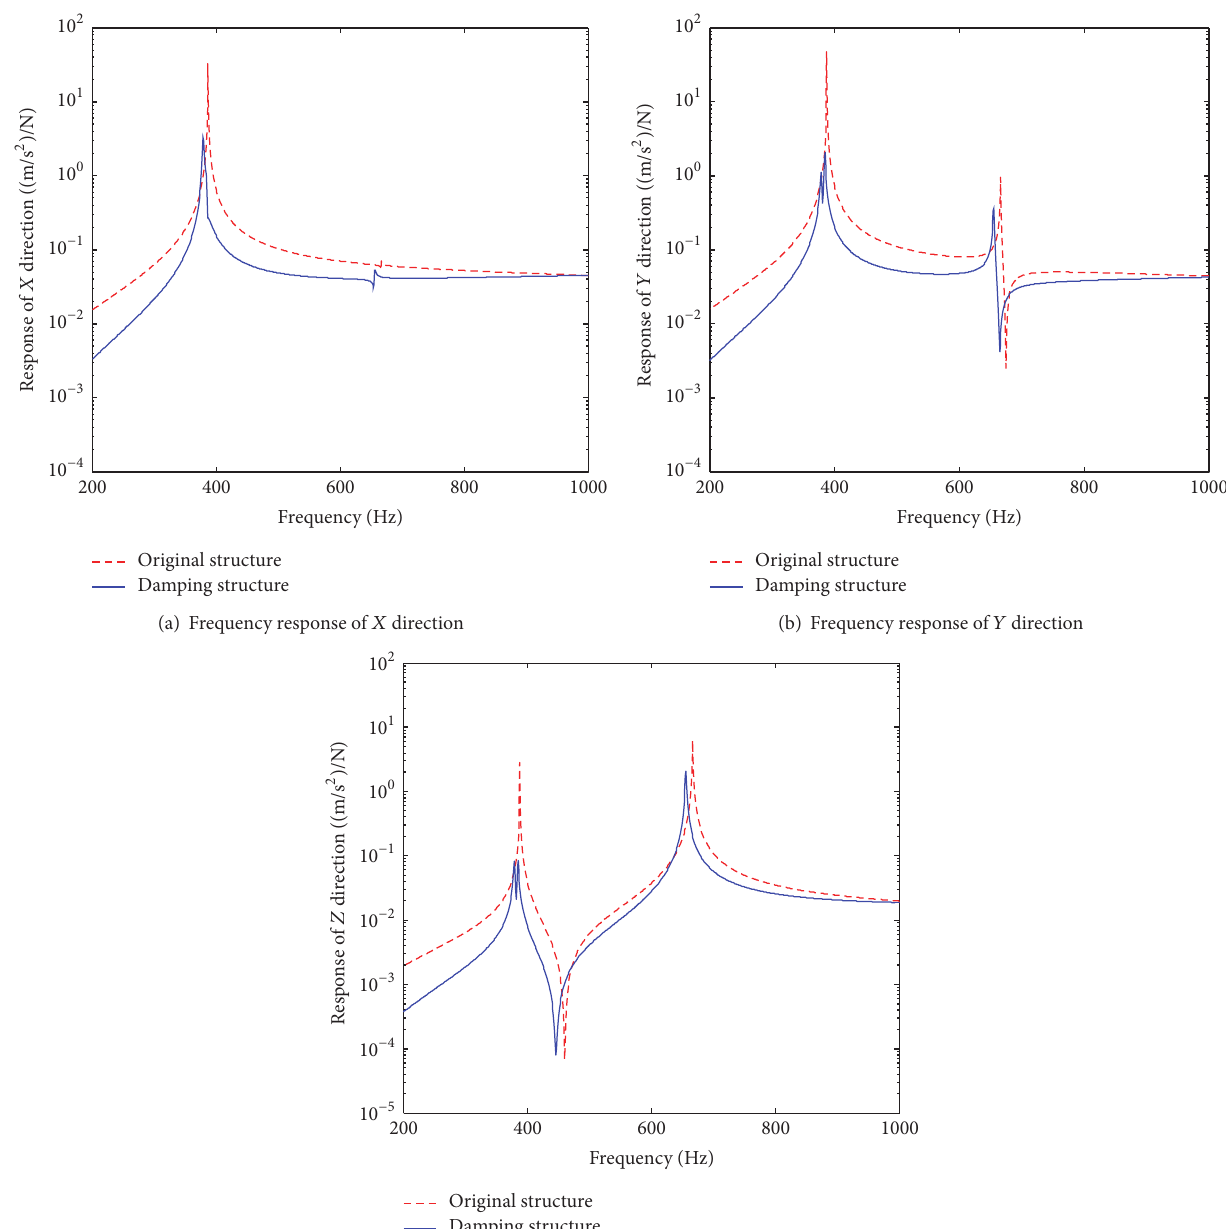
Figure 11: Frequency response of headstock with damping material and original structure.